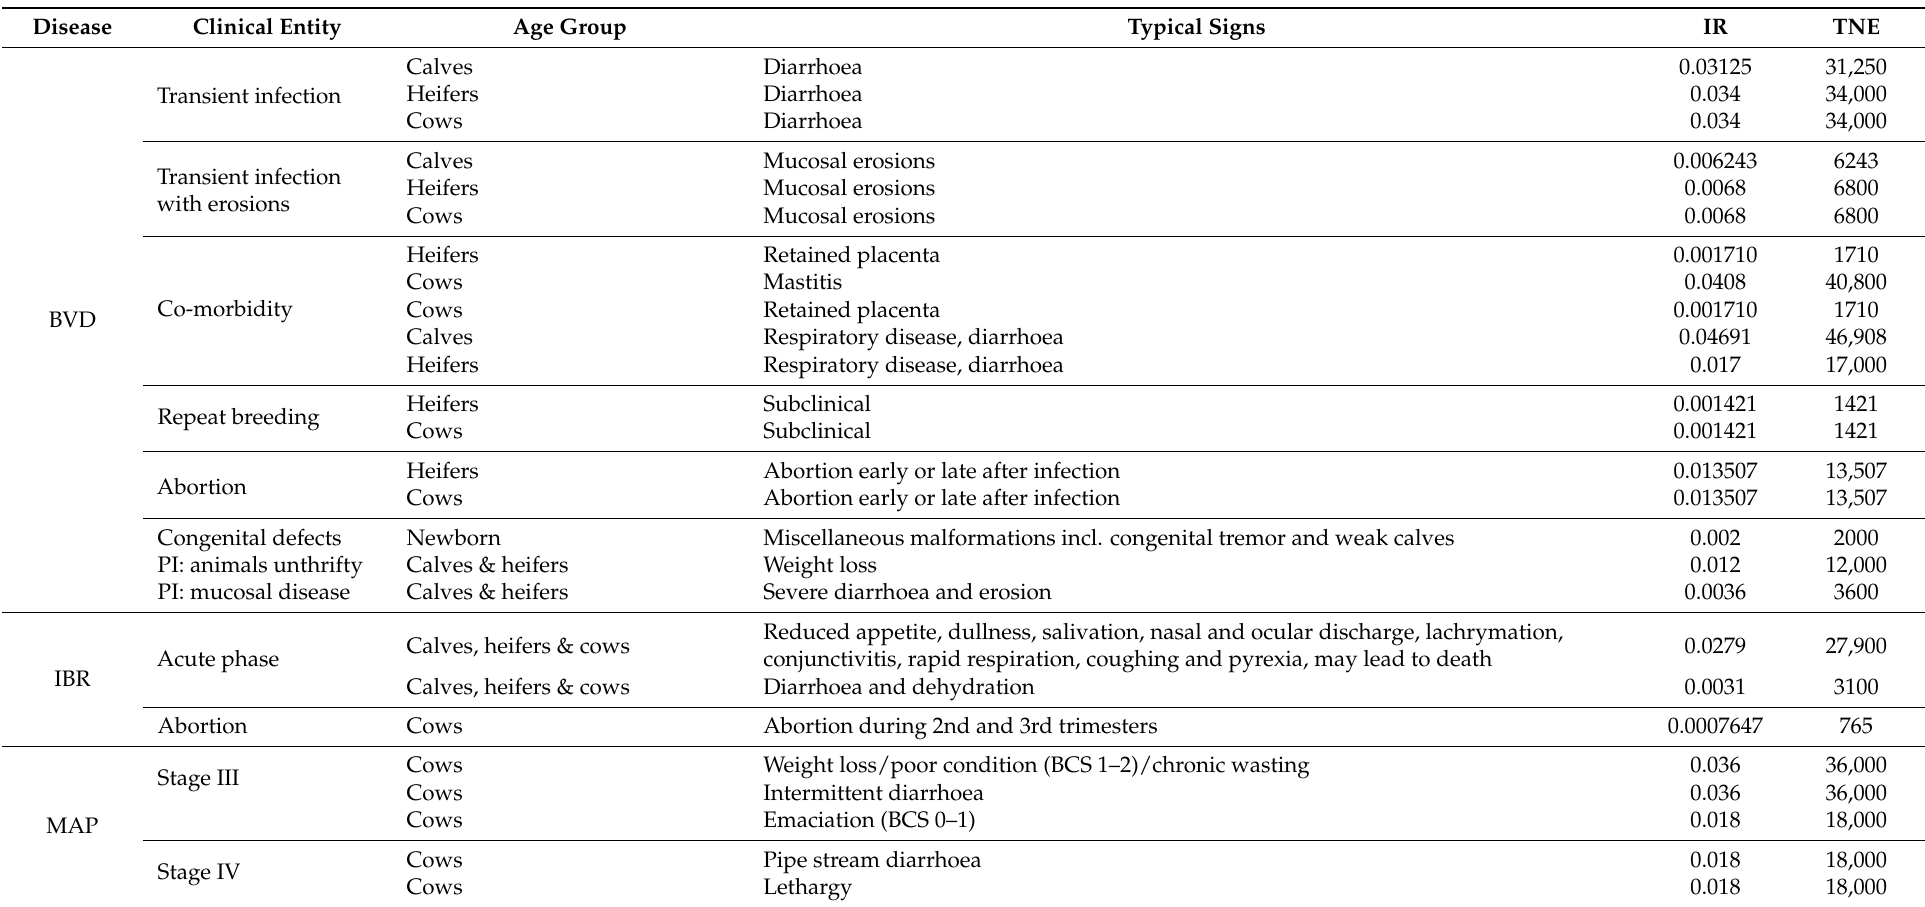
Table 4. Annual incidence risk (IR) and total number of events (TNE) per 1 million animals for each clinical entity for the five diseases 1 and ten non-infectious welfare hazards.